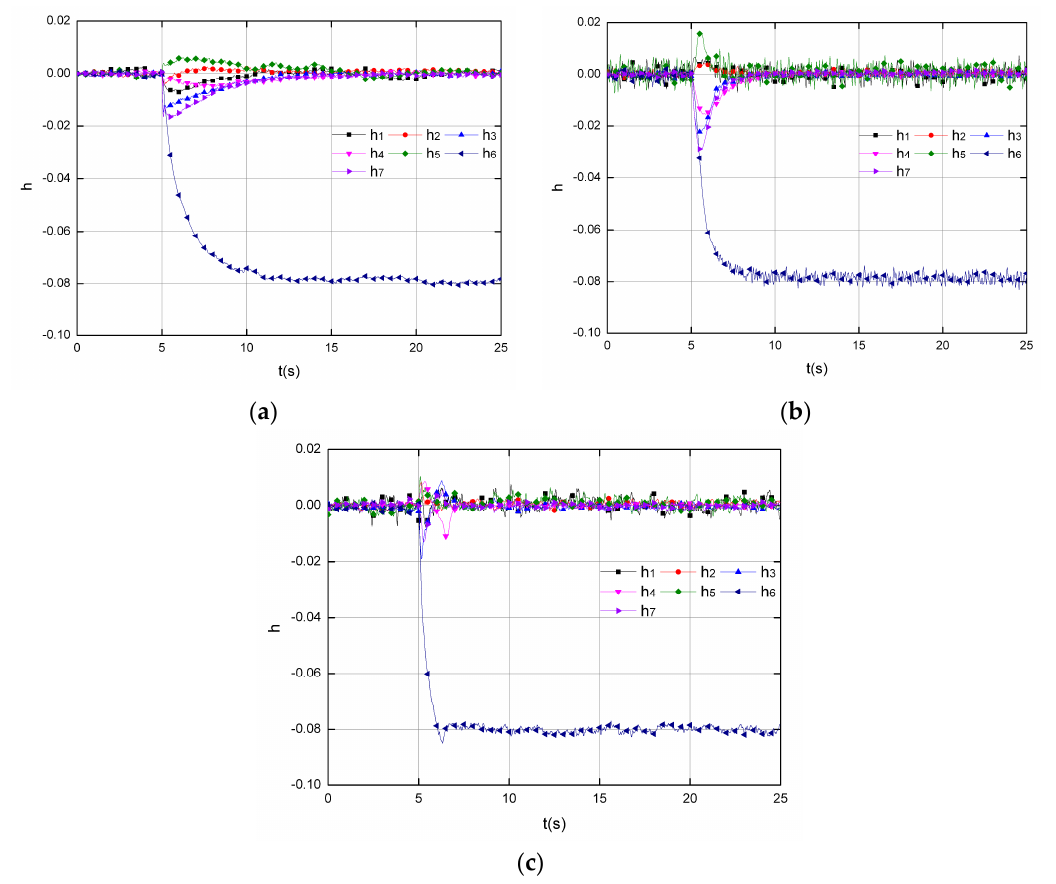
Figure 4. The health estimation corresponding to the injected 8% decrease on h 6 that is applied at t = 5 s (Mode 1) in scenarios without uncertainties. ( a ) Results by KF; ( b ) Results by SMO; ( c ) Results by SOSMO.